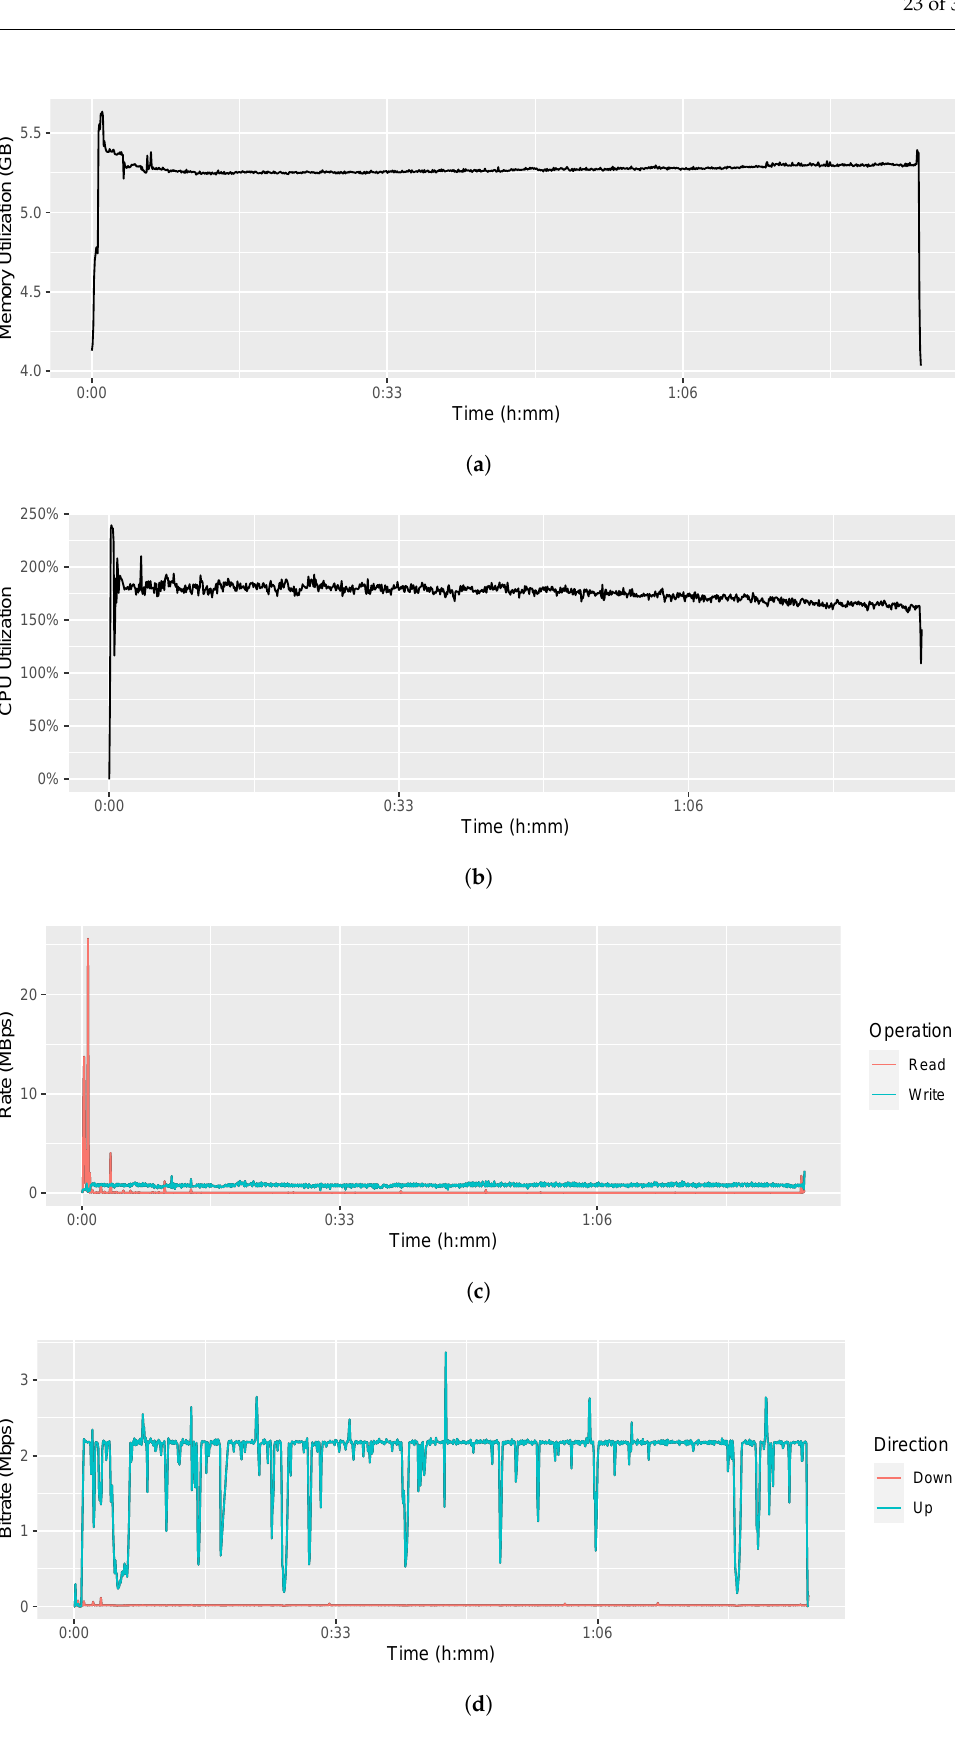
Figure 23. Performance evaluation of the Aggregator Device. ( a ) Memory utilization. ( b ) CPU utilization. ( c ) I/O disk utilization. ( d ) Network